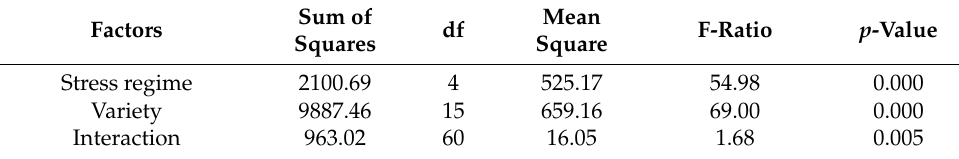
Table A1. Two-ways analysis of variation (ANOVA) done for seeds